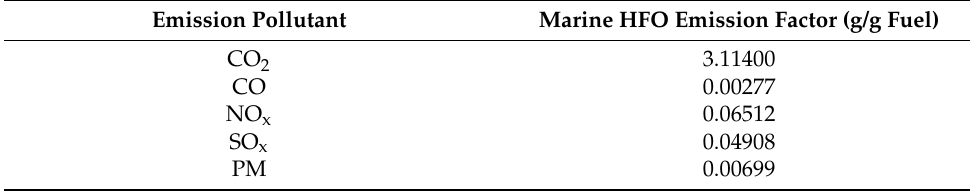
Table 4. Emission factors of